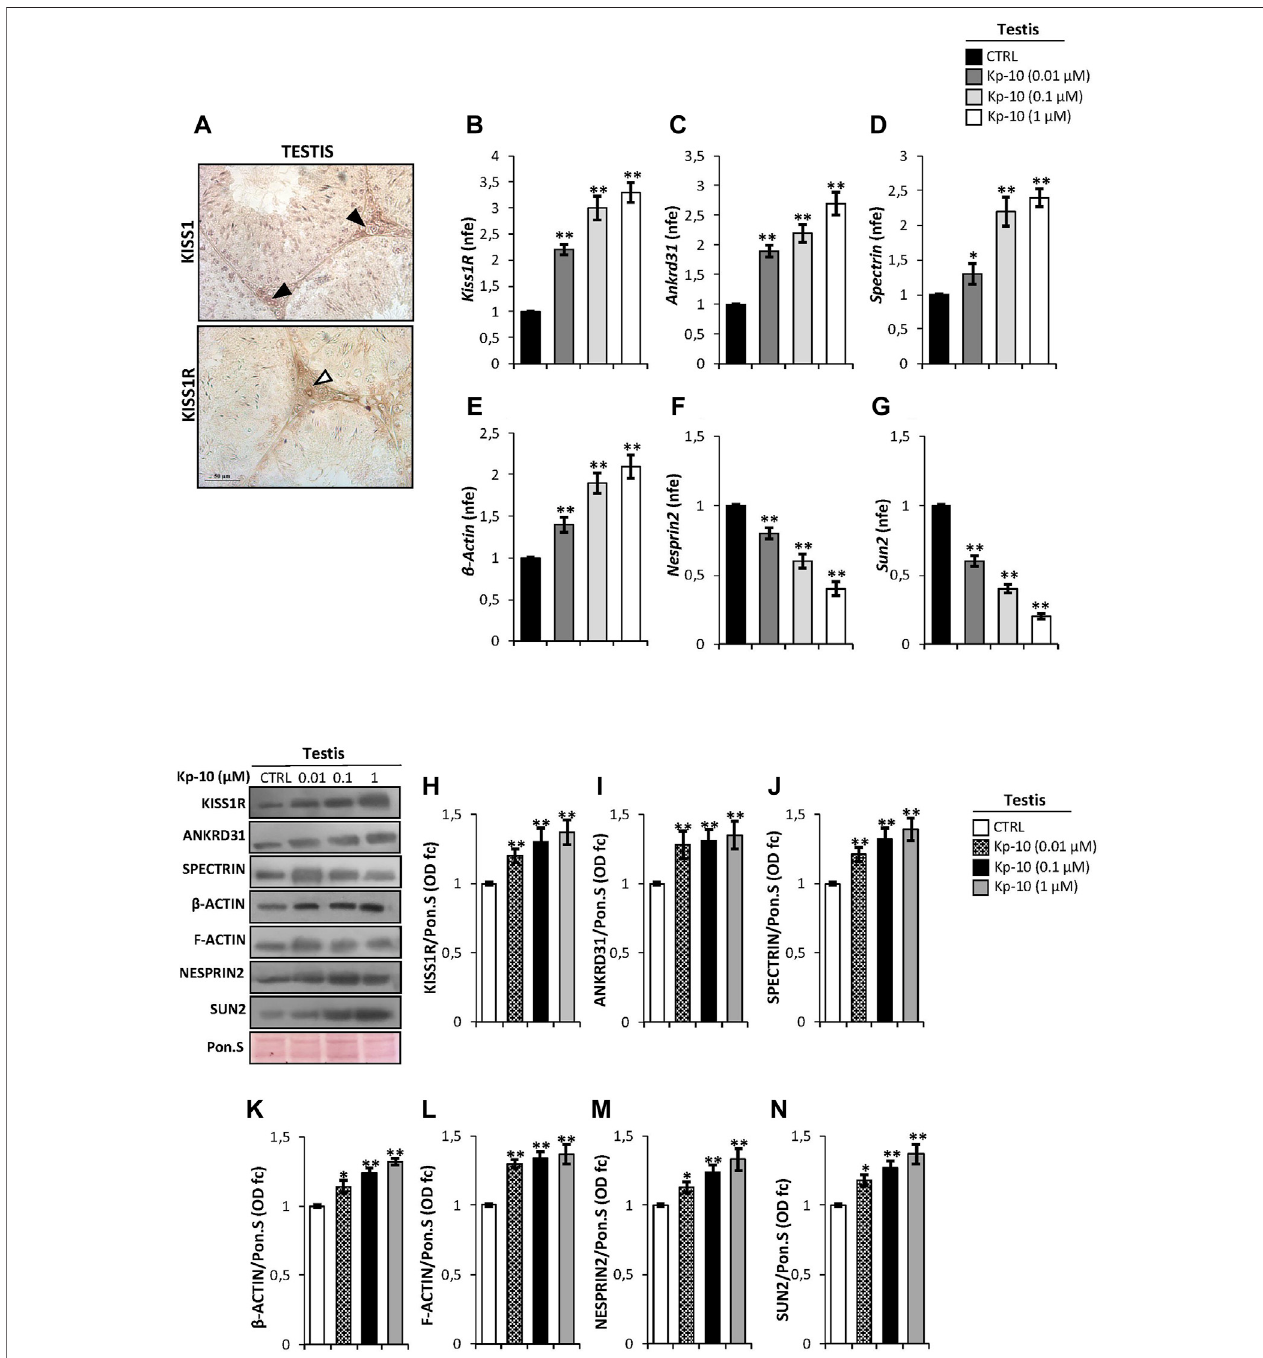
FIGURE 1 | (A) Immunocytochemistry ofKISS1 and KISS1R in Bouin ’ s fi xed C57BL/6 testis sections (7 μ m). The KISS1 and KISS1R protein localization in Leydig cells was indicated by black and white arrowheads, respectively. Scale bar: 50 μ m. (B – G) Differential expression analysis of KissR and cytoskeletal – nucleoskeletal pathwaymediatormRNAsinmicetestes invitro treatedwithdifferentdosesofKp-10(0.01 µM,0.1 µM,and1 µM),byqRT-PCR. (B) Kiss1R , (C) Ankrd31 , (D) Spectrin , (E) β -Actin , (F) Nesprin2 , and (G) Sun2 expression levels were normalized using Rp18S as a housekeeping gene and expressed as normalized fold expression (n.f.e.), relatively to the CTRL group. All data are reported as mean value ± S.E.M; * p < 0.05; ** p < 0.01. Western blot analysis of (H) KISS1R, (I) ANKRD31, (J) SPECTRIN- α -II, (K) β -actin, (L) F-actin, (M) NESPRIN2, and (N) SUN2 proteins levels in mice testes in vitro treated with different doses of Kp-10 (0.01 µM, 0.1 µM, and 1 µM).Signalswerequanti fi edbythedensitometryanalysisandnormalizedtoPonceauRed(Pon.S).DataareexpressedinO.D.valuesasfoldchange(O.D.fc),relatively to the CTRL group, and reported as mean ± SEM; * p < 0.05; ** p < 0.01.